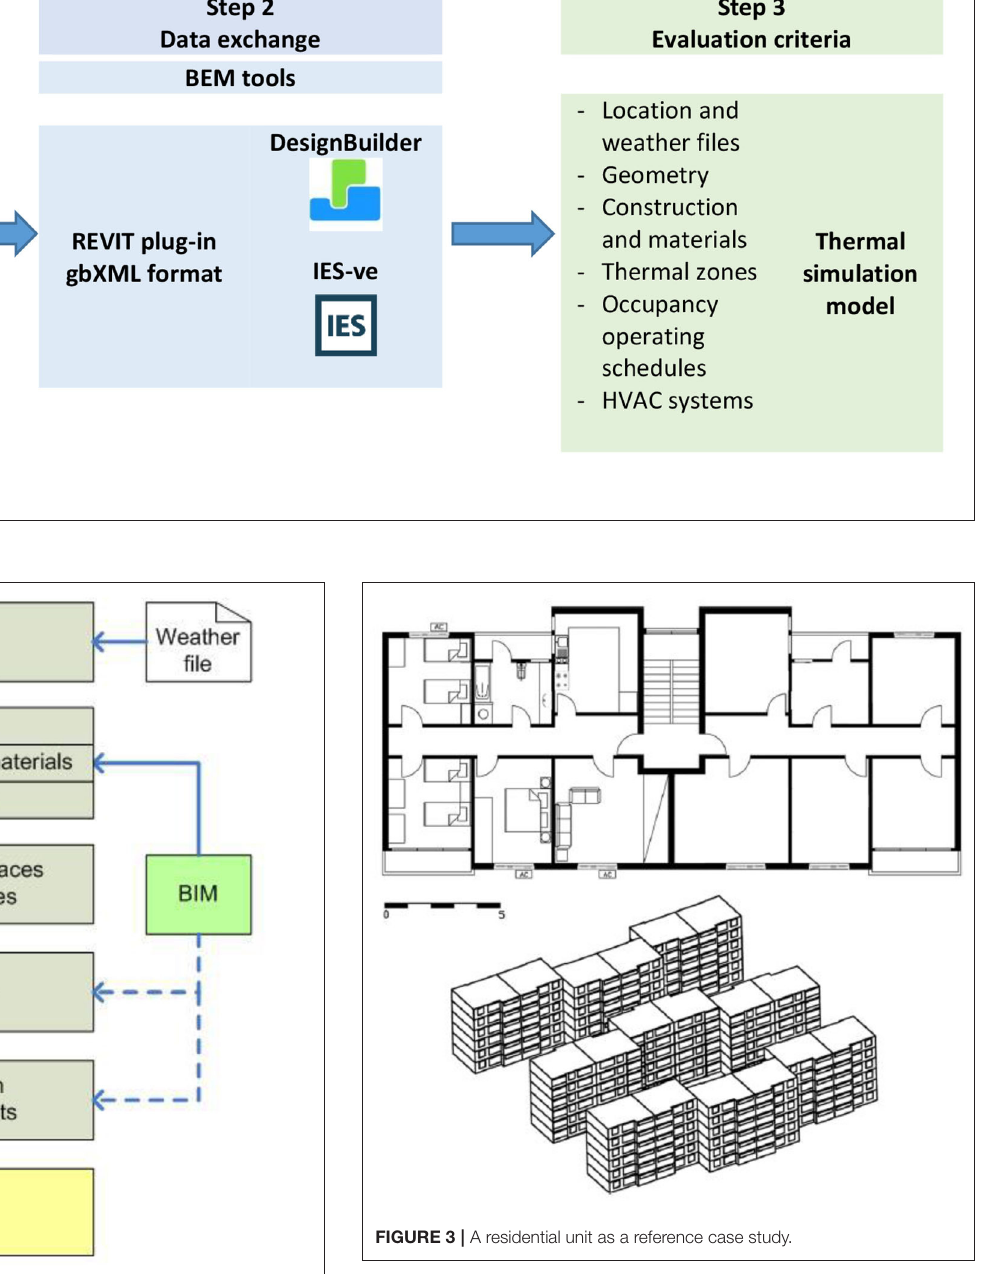
FIGURE 2 | Ideal workflow for BEM tools (Maile et al., 2007).